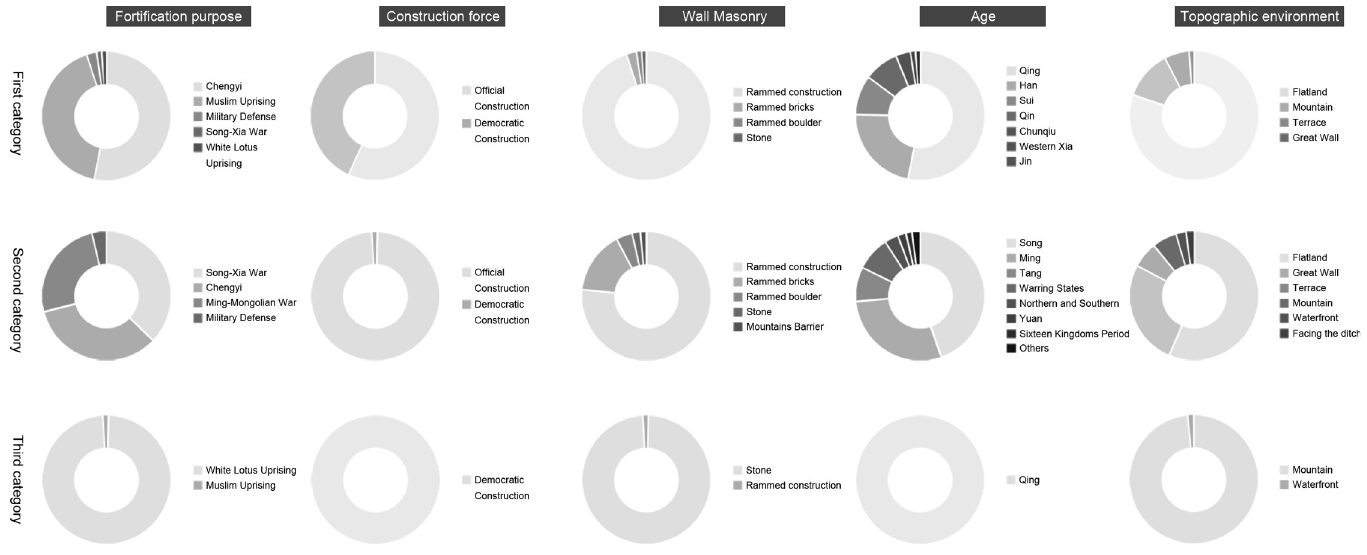
Fig 10. Type factors statistical